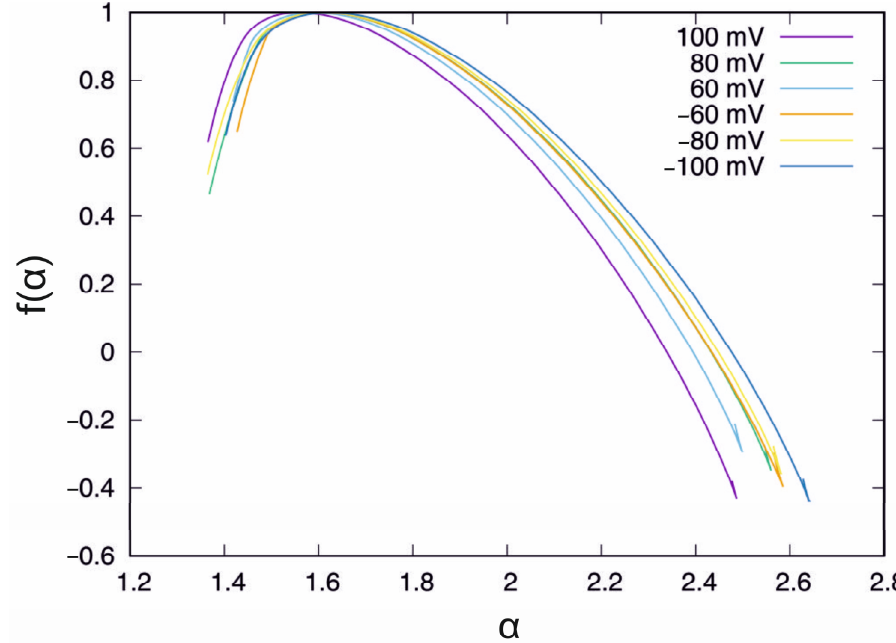
Figure 3. Singularity spectrum f( α ) obtained for the given set of external potentials.